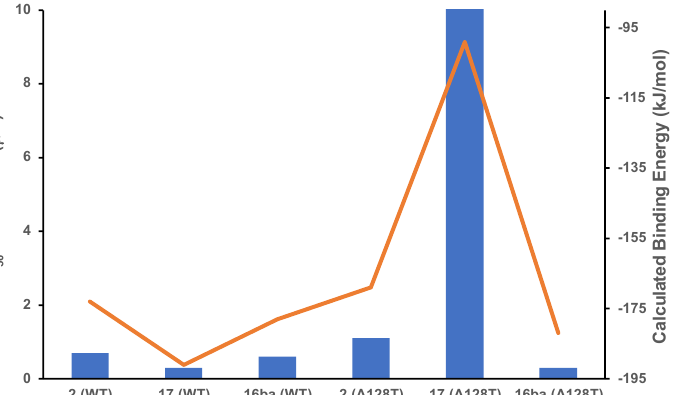
Figure 4. Antiviral activities and Calculated Binding Energy. The antiviral IC 50 for each compound with the WT or IN A128T mutant is shown with blue bars (values extracted from Table 5). The orange line shows the calculated binding energy for each compound with the WT or IN A128T mutant.